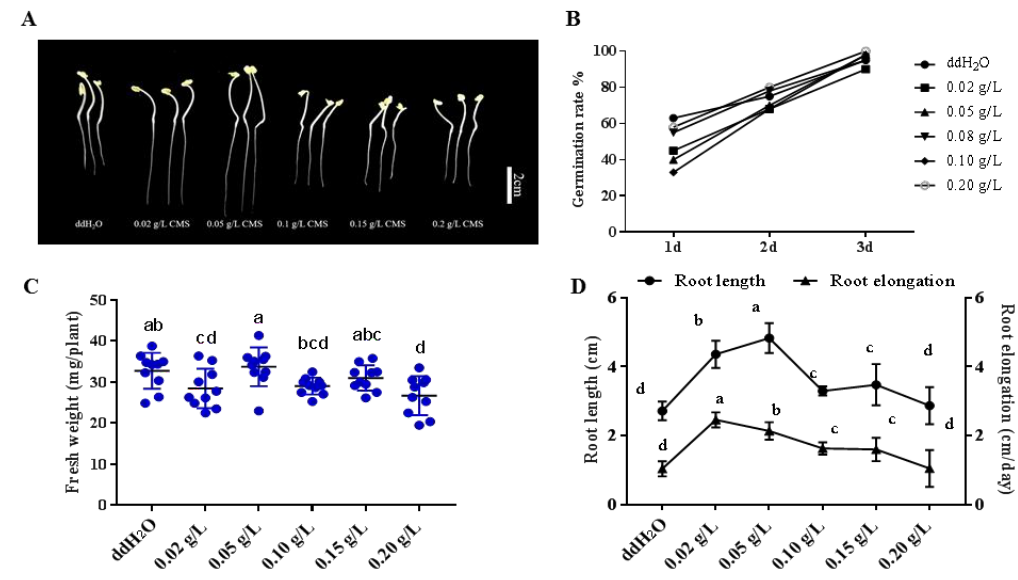
Figure 1. E ff ects of di ff erent concentrations of CMS on Brassica napus seedling growth ( A ), germination ( B ), fresh weight ( C ) and root growth ( D ). 1d, 2d, 3d indicate 1, 2, 3 days after sowing. Di ff erent letters indicate the significant di ff erences at p < 0.05 by Duncan’s test. N = 10.